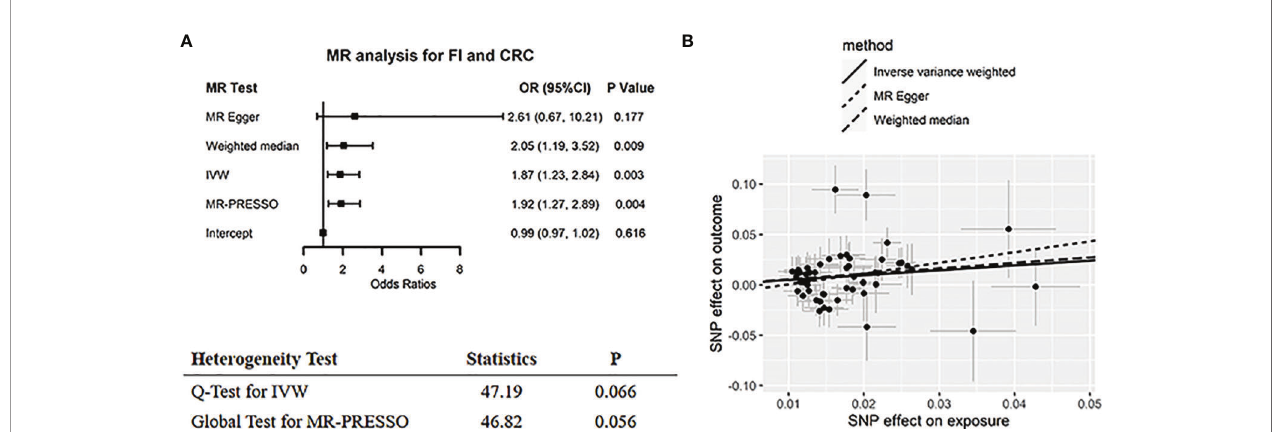
FIGURE 2 | Two-sample MR analysis results of FI on colorectal cancer. (A) Forest plot for summarizing the results of all MR methods. The black box represents the effect estimates, and the error line represents the 95% CI. (B) Scatter plot for comparison of MR methods. The black circle represents the point effect estimate, and the slope represents the correlation trend. FI, fasting insulin; CRC, colorectal cancer; MR, Mendelian randomization; IVW, inverse-variance weighted; MR-PRESSO, MR pleiotropy residual sum and outlier test; OR, odds